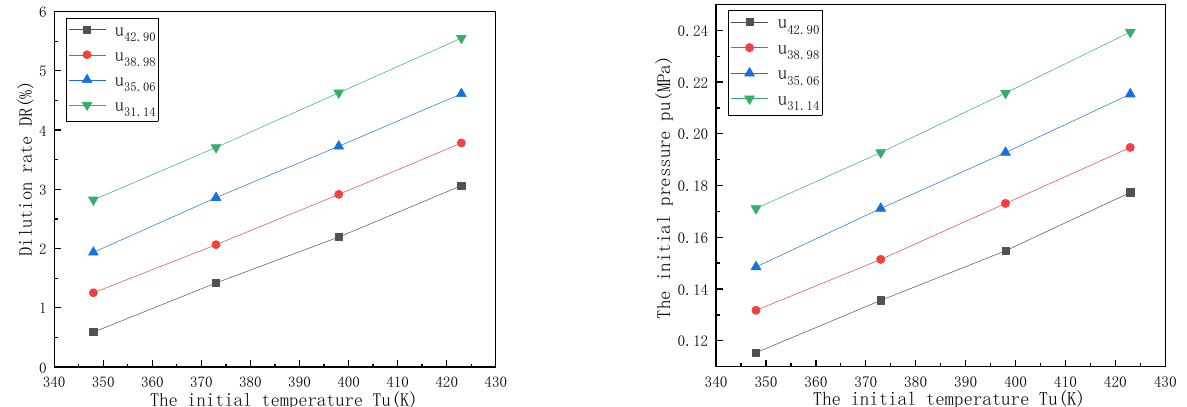
Figure 14. Equivalent variation in u L corresponding to the initial condition change with Tu.